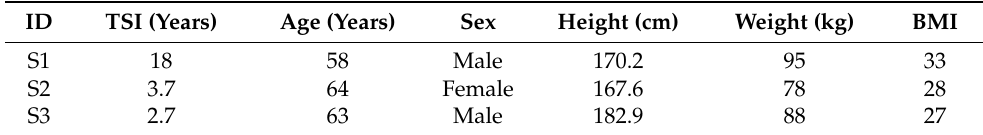
Table 1. AllCore360 ◦ rotations. TSI, time since injury; BMI, body mass